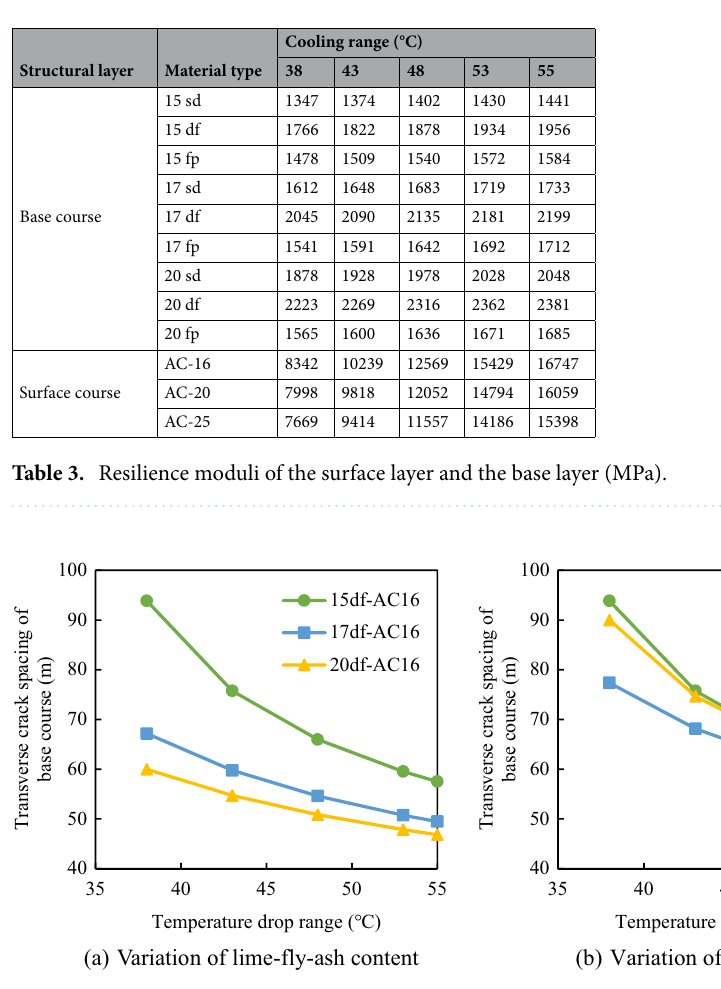
Figure 12. Variation of transverse crack spacing in the base course with the cooling